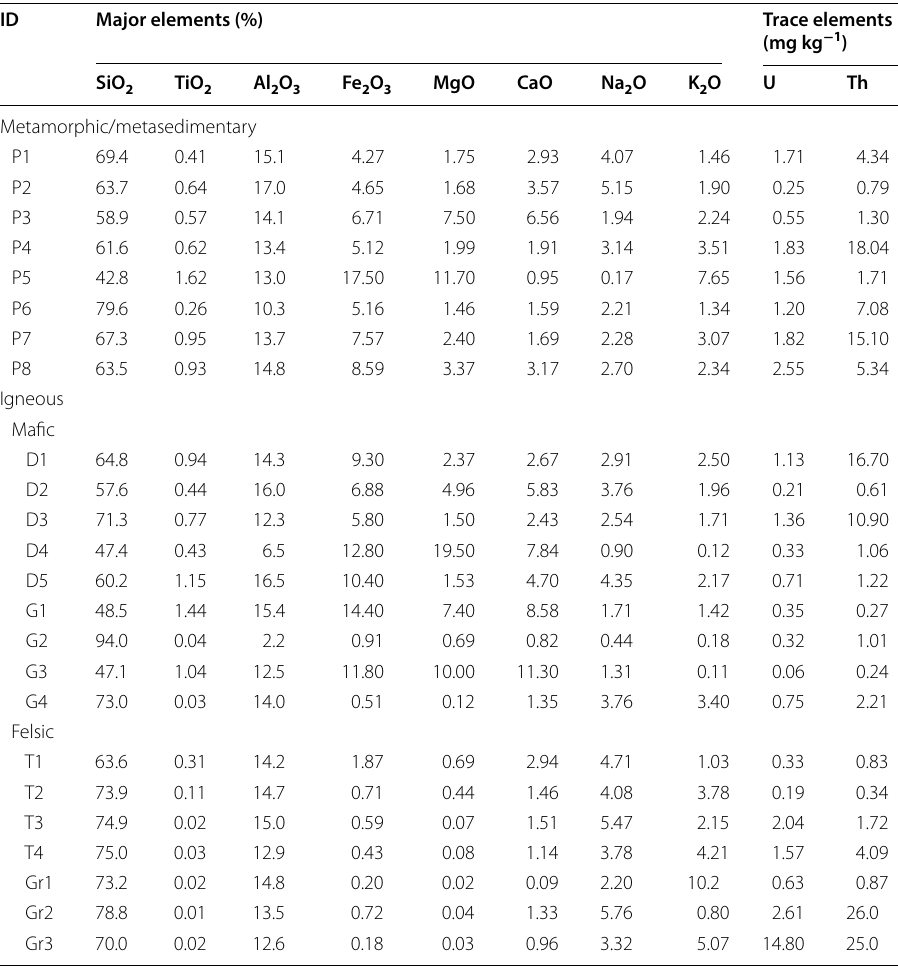
P paragneiss, D diorite, G gabbro, T tonalite, Gr granite